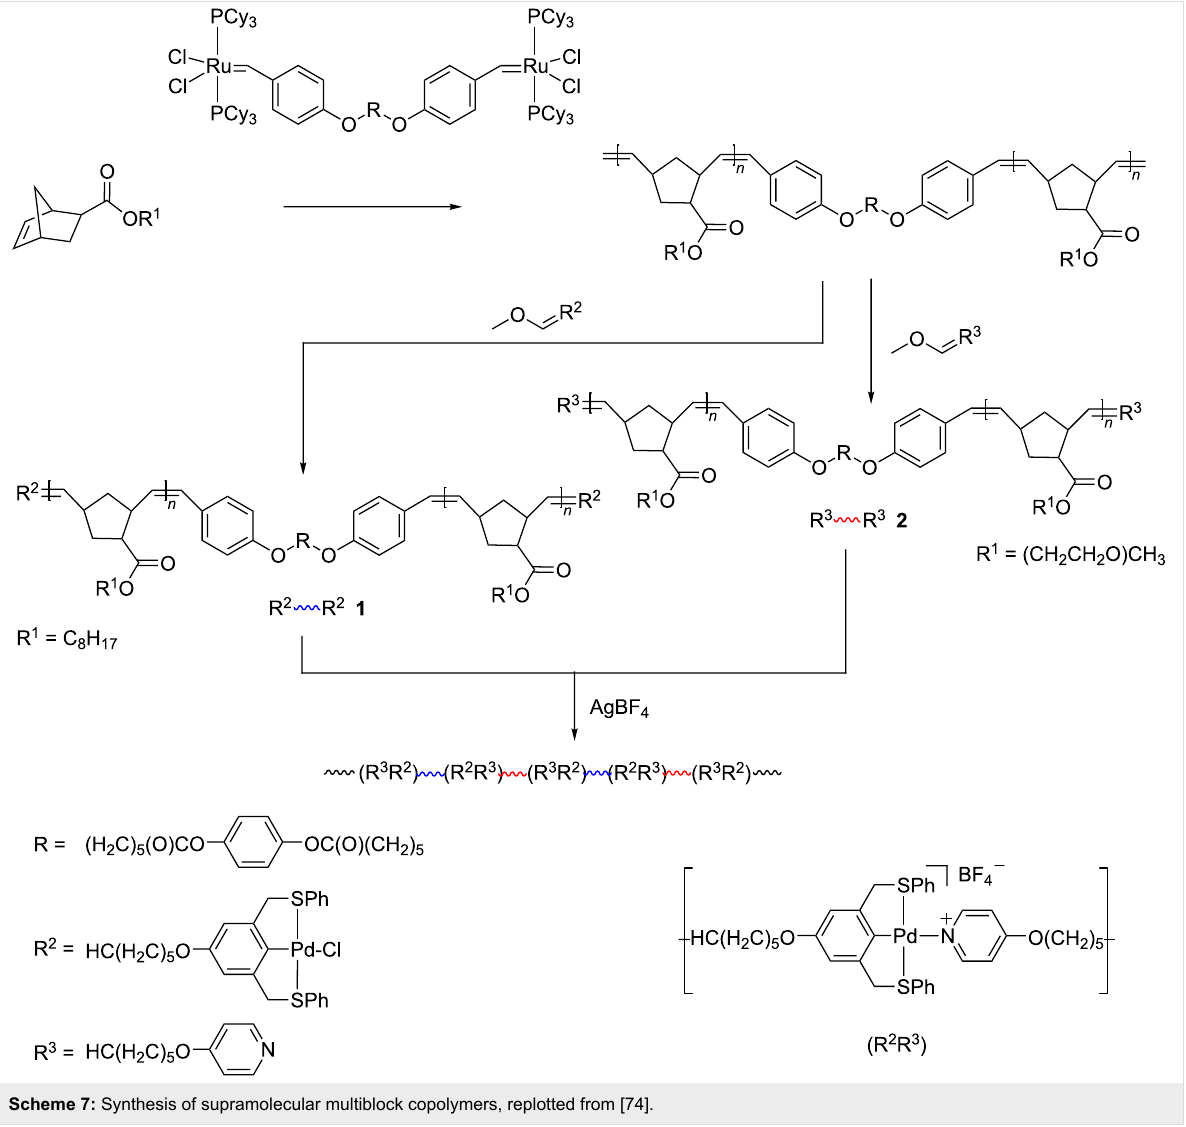
Scheme 7: Synthesis of supramolecular multiblock copolymers, replotted from [74].